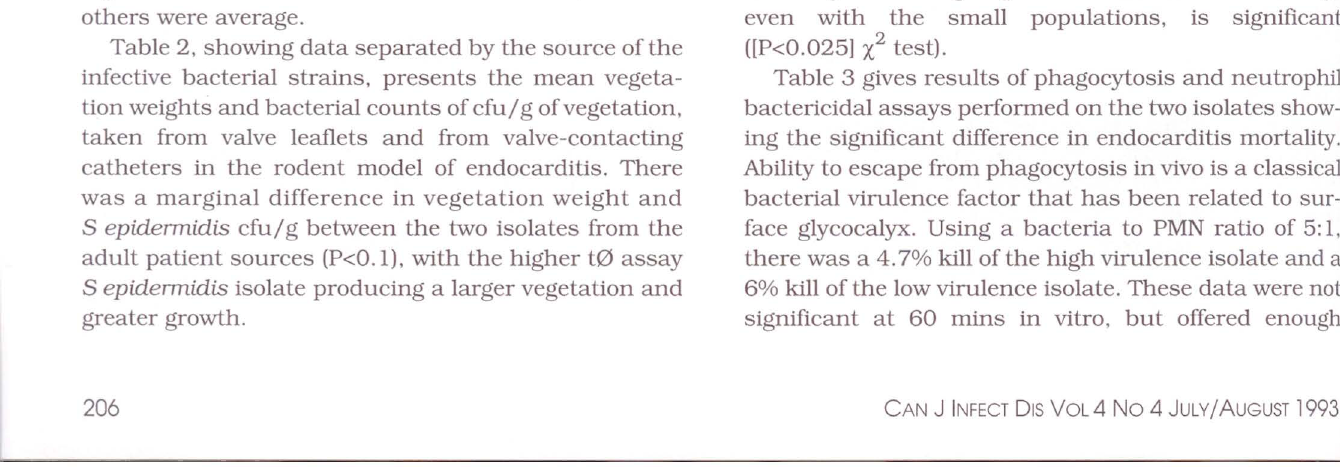
Endocarditis model: Comparing isolates of Staphylococcus epidermidis Tests 1 to 4, adult isolates· Tests 5 and 6, pediatric isolatest